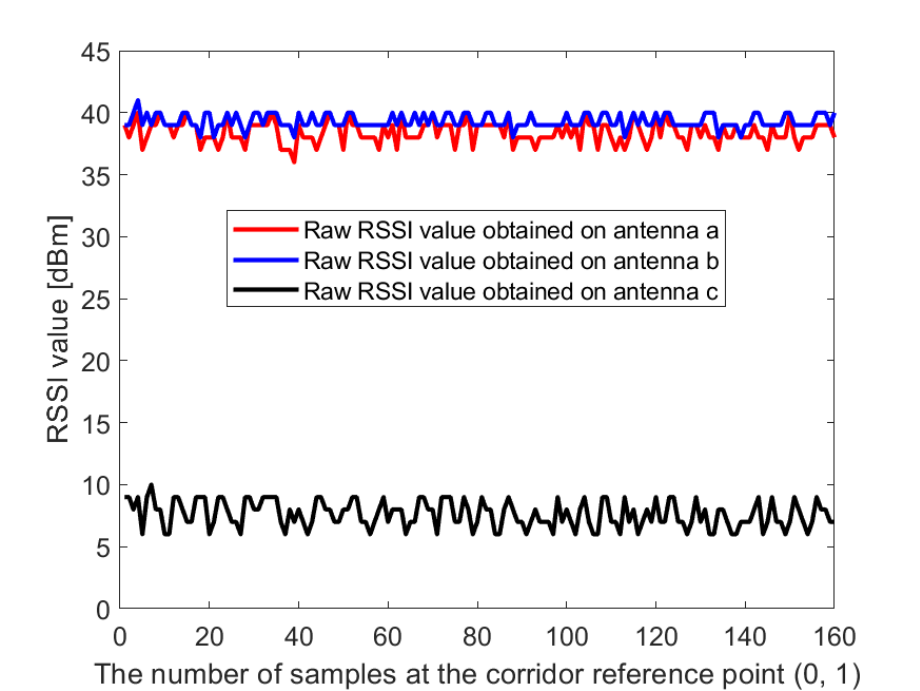
Figure 2. The raw RSSI value of access point AP1 obtained at the reference point (0,1) in the corridor of IT1 building.